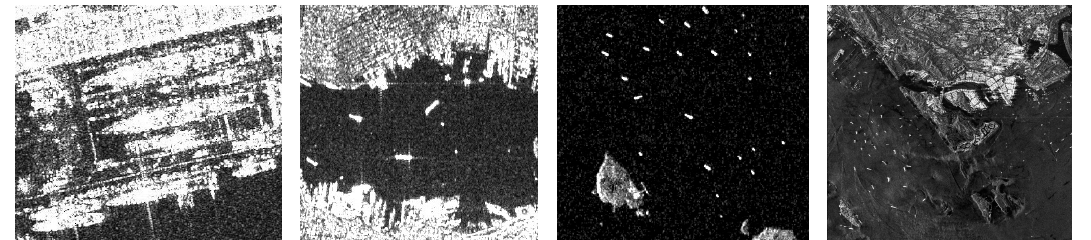
Figure 1. Examples of ships in the high-resolution SAR imagery.